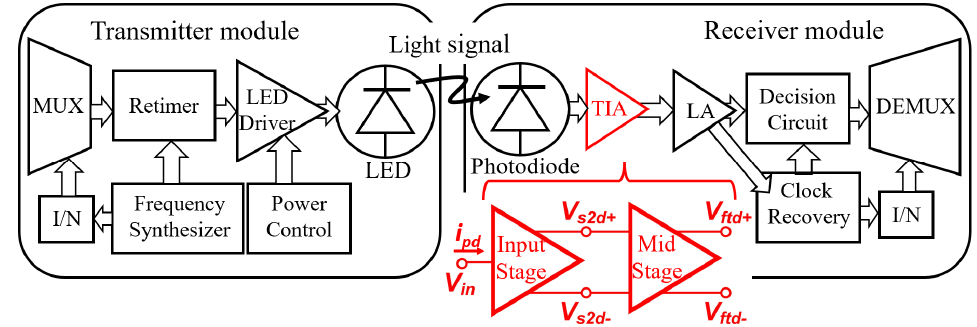
Figure 1. Architecture of the transmitter and receiver modules of the VLC system.